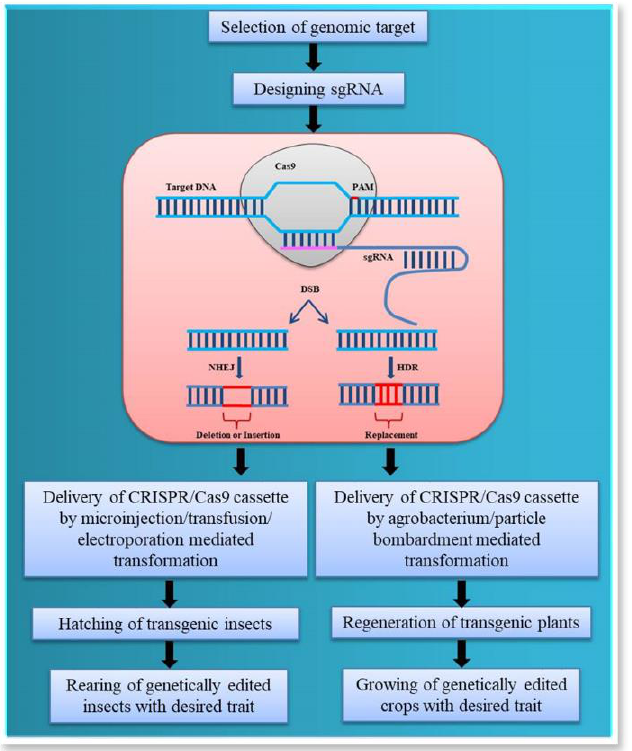
Figure 1. Workflow for CRISPR-Cas9-based genome editing in insects and plants for insect resistance.